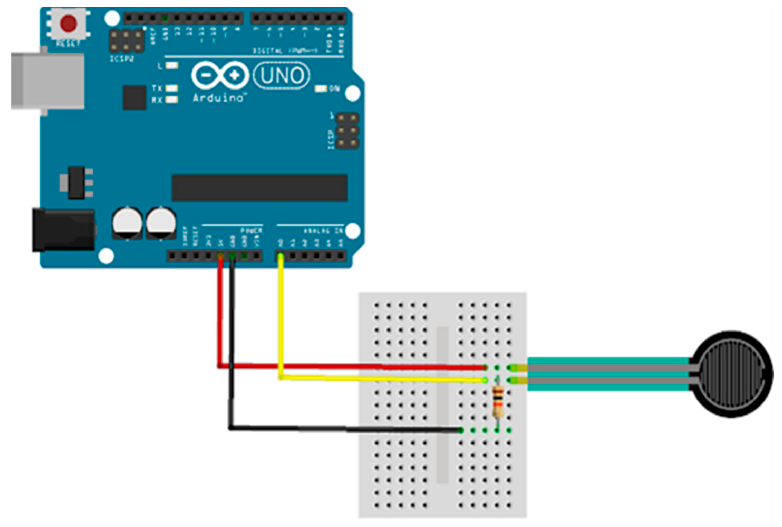
Figure A2. Pressure-Sensitive Epiglottis model’s circuit.